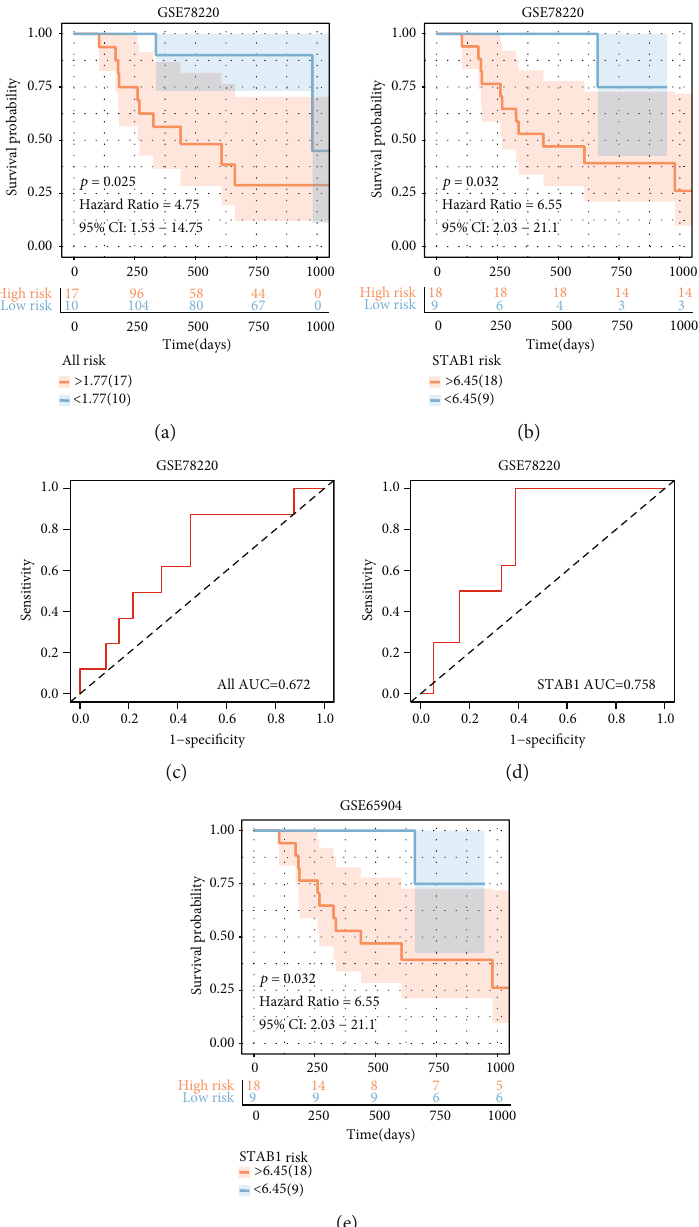
Figure 9: (a – d) External immunotherapy follow-up cohort validation of the model. In GSE78220, there was a signi fi cant di ff erence in survival between the high-risk and low-risk groups, and patients with higher levels of STAB1 had a worse prognosis. (e) The low STAB1 expression group had a better e ff ect on immunotherapy in